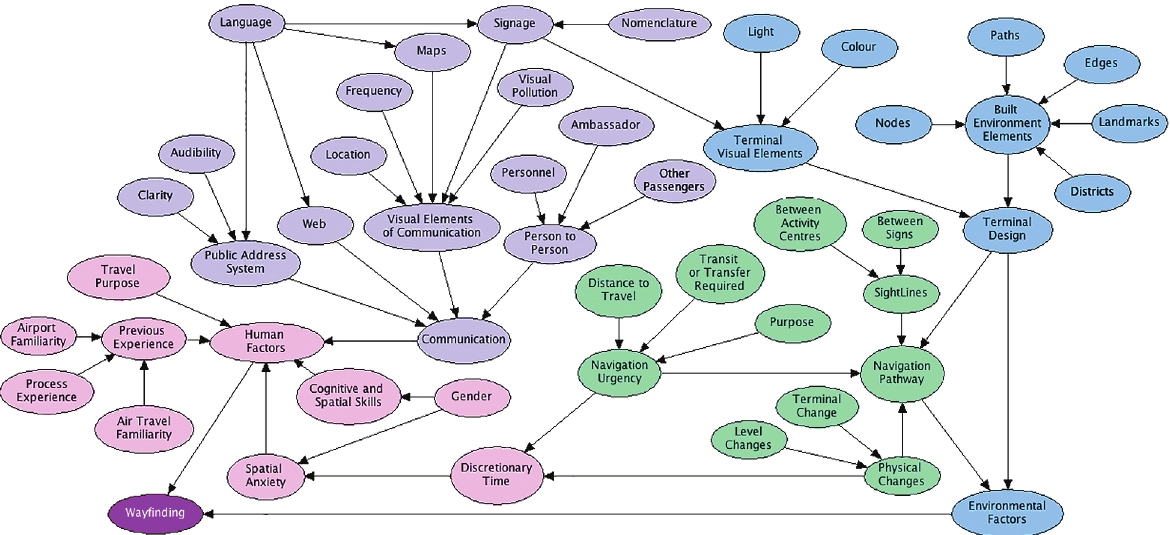
Fig. 1. The Wayfinding Bayesian Network (variables of interest are represented as nodes, and arcs show the direction of the dependencies between the variables; variables related to ‘Human Factors’ are shown in pink; light blue represent variables pertaining to the built environment in the airport; green represents the variables relevant to navigation pathway; variables pertinent to communication are in light purple; and the node of interest ‘Wayfinding’ can be seen in dark